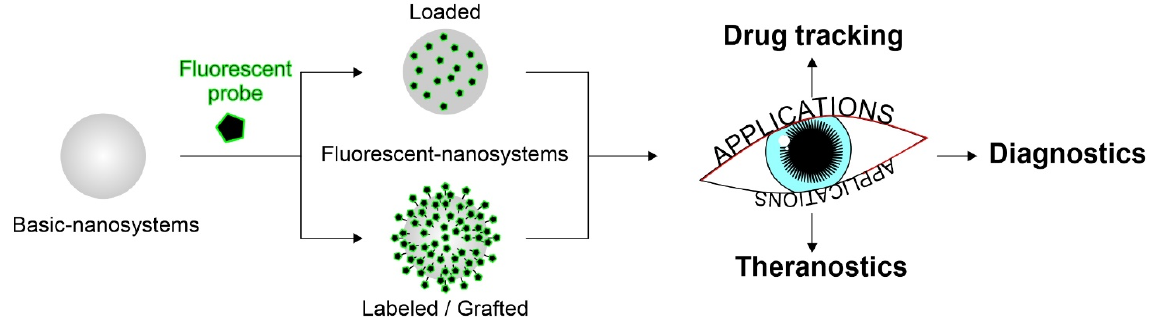
Figure 3. Schematic structure of fluorescent nanosystems for ocular applications.